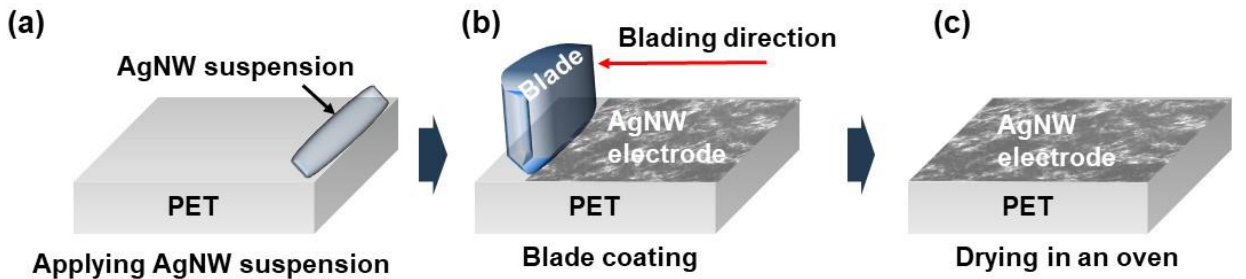
Figure 1. ( a – c ) Schematics of the coating process for the production of transparent Ag nanowire electrodes using a doctor blade system.